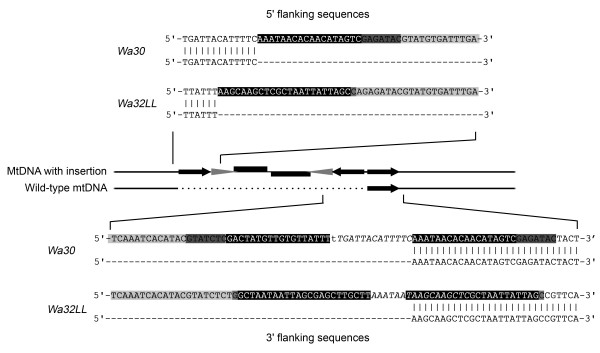
Plasmid integration results in de novo generated mtDNA inversions. An alignment is given of the 5' and 3' plasmid flanking sequences from the integrations in Wa30 and Wa32-LL with wild-type mtDNA regions from juvenile cultures of the corresponding strains. As in Table 1, plasmid sequences are indicated in grey, with potential homology to the mitochondrial sequences in dark grey. Duplications are indicated in black. The actual duplications are slightly larger than thus indicated (i.e. both in Wa30 and in Wa32-LL one of the 3' duplications extends further than the other, indicated in italics). Note the linker at the secondary recombination junction of Wa30 (small font).